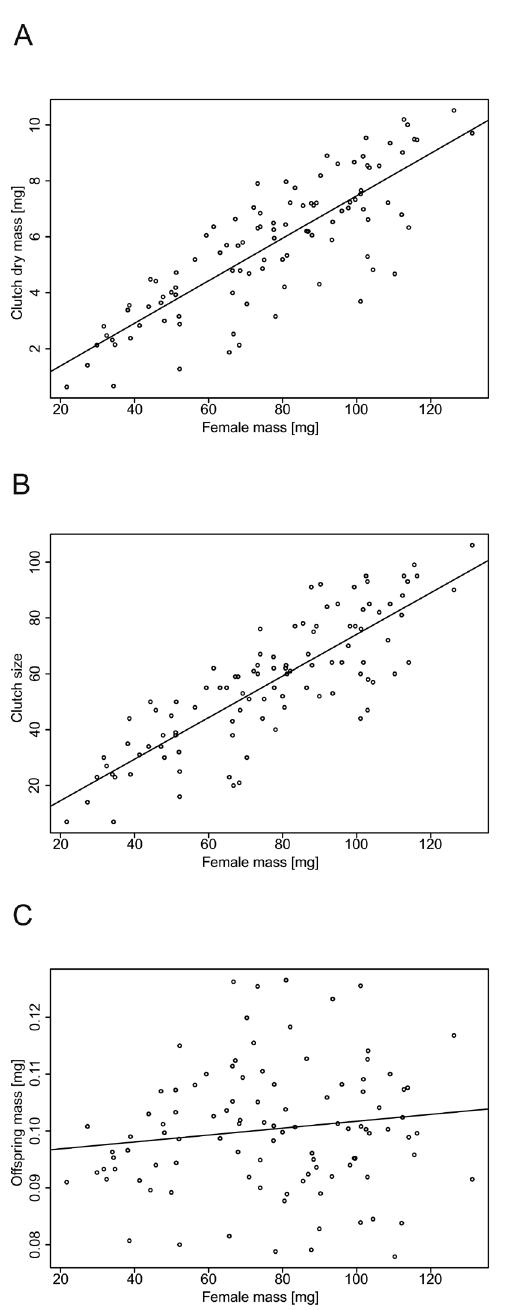
Figure 1. In Porcellio scaber , the dry mass of clutches ( A ) and clutch size ( B ) increased linearly with female body mass, but the mean dry mass of offspring did not depend on female mass in a consistent way ( C ). Lines represent fitted regressions A y = -0.13+0.08x (r = 0.83, p<0.001) B y = -0.32+0.74x (r = 0.83, p<0.001) C y = 0.1+0.00006x (r = 0.14, p =